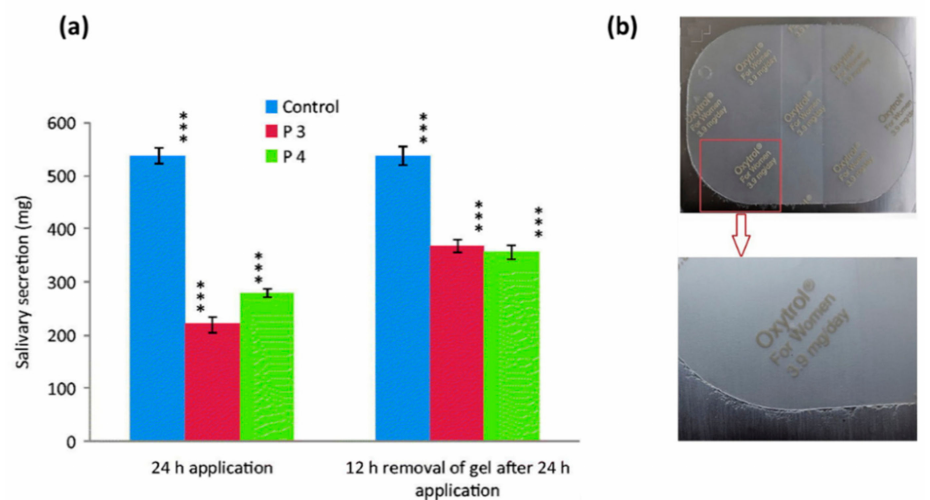
Figure 5. ( a ) Recovery of pilocarpine-induced salivation secretion in rats after transdermal adminis- tration of oxybutynin chloride. Statistically significant data ( p < 0.05 = ***). Reprinted with permission from ref. [47]. Copyright © 2016 Taylor & Francis. ( b ) Appearance of commercial product in primary package. Reprinted with permission from ref. [48]. Copyright 2018